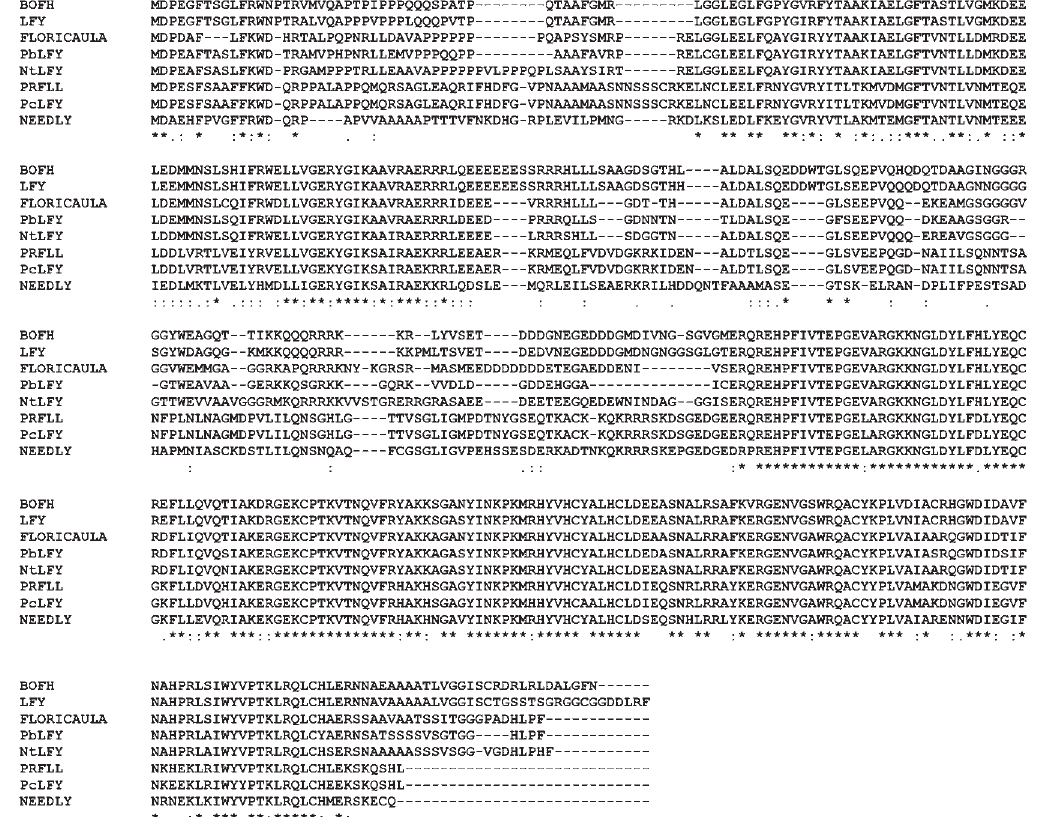
Figure 2 - Alignment of deduced amino acid LFY-like complete sequences with PcLFY. Sequences include: NEEDLY and PRFLL from radiata pine (Mouradov et al ., 1998; Mellerowicz et al ., 1998); PbLEAFY: LFY-like protein of Populus balsamifera (GenBank accession number U93196); NtLFY from Nicotiana tabacum (Kelly et al ., 1995); Leafy from Arabidopsis thaliana (Weigel et al ., 1992); FLO from Antirrhinum majus (Coen et al ., 1990), BOFHfrom Brassicaoleracea (Anthony etal .,1993).Identicalresiduesaremarkedbyasterisks,similarresiduesaremarkedbydots,gapsaremarkedby